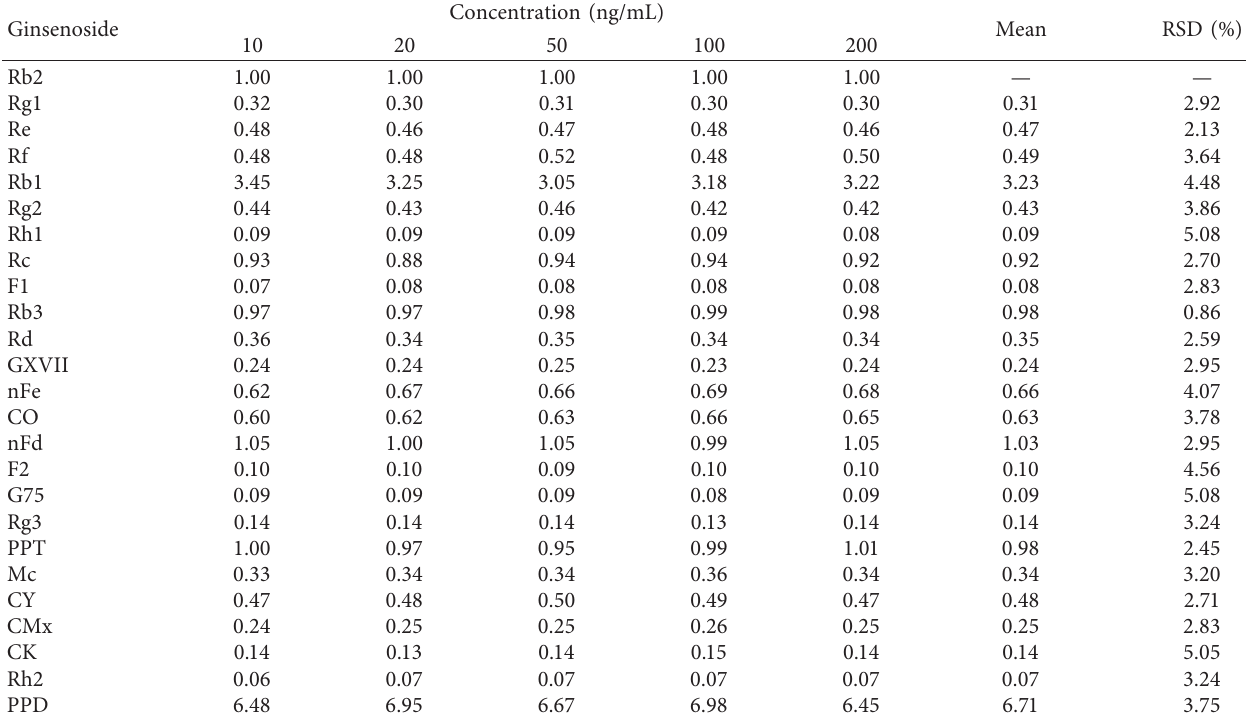
Table 5: Effects of column temperature and flow rate upon relative response factor (RCF) and relative retention time (RT Effects of column temperature Effects of flow rate